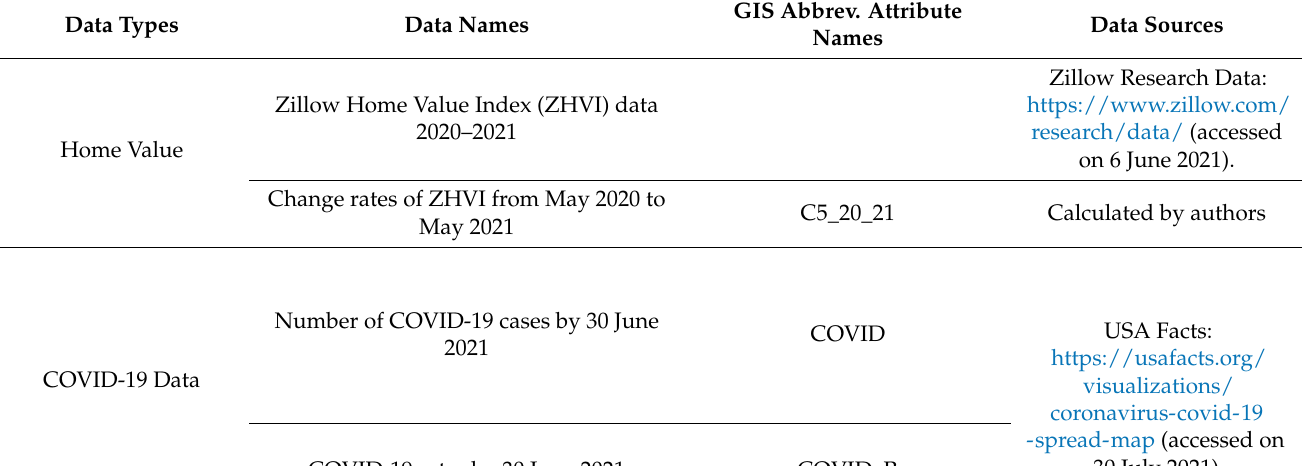
Table 1. Data names and